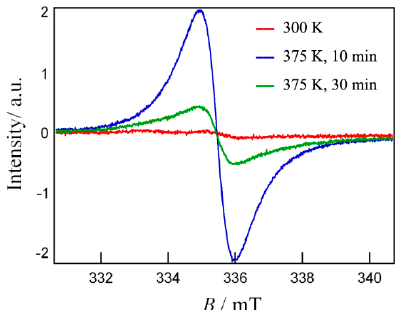
Figure 8. ESR spectra of 5F2MeBPBN, measured in the following sequence: (1) a solid state at 300 K, (2) a liquid state after being kept at 375 K for 10 min and (3) at the same temperature after 30 min.